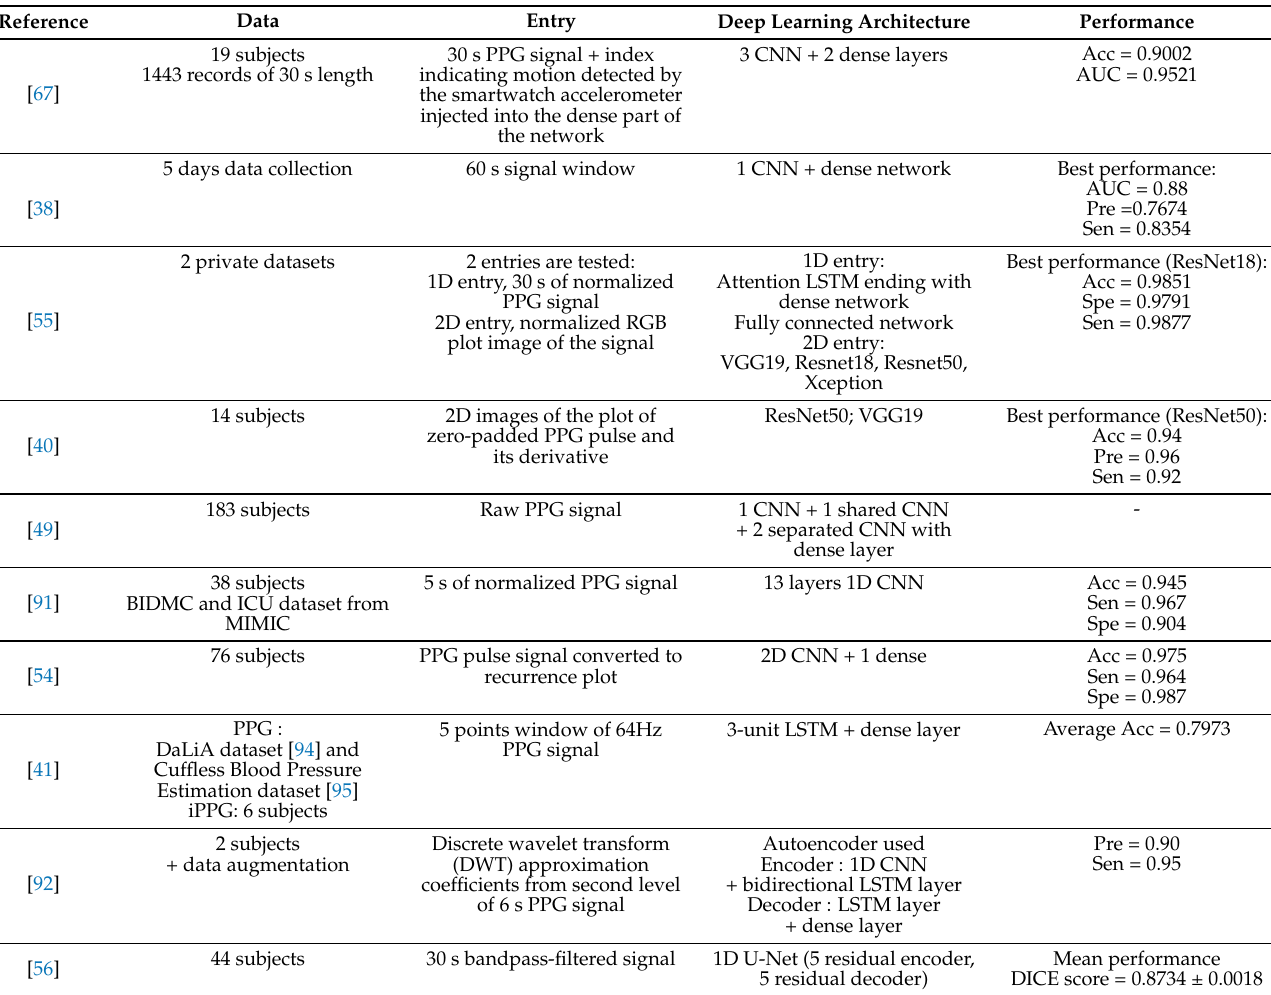
Table 7. Summary of deep learning-based quality assessment